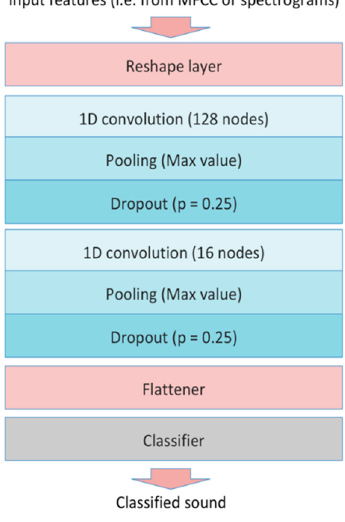
Figure 7. Neural network configuration.